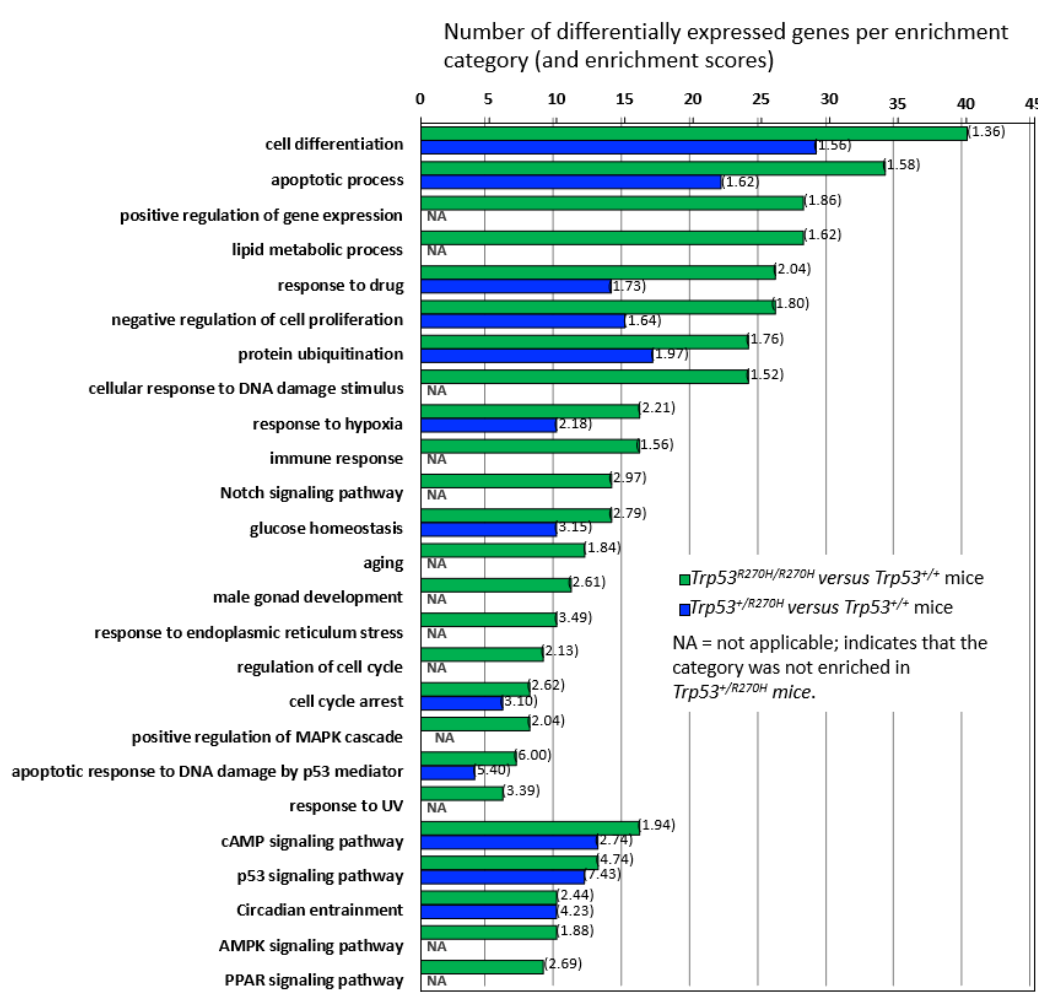
Figure 3. Gene enrichment analysis and gene dosage effects. Comparison of differential gene expression in Trp53 R270H homozygous versus wildtype mice and in Trp53 R270H heterozygous versus wildtype mice by gene enrichment category demonstrates that gene dosage differences exist for many, but not all of the categories. Gene enrichment scores are shown in brackets.